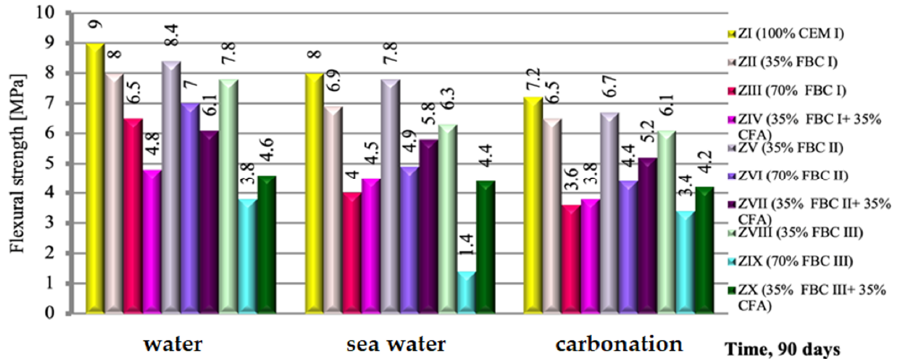
Figure 9. The flexural strength of mortars containing FBC fly ashes of different origins and mixtures of FBC and conventional fly ashes, cured in tap water, seawater and the carbonation process.